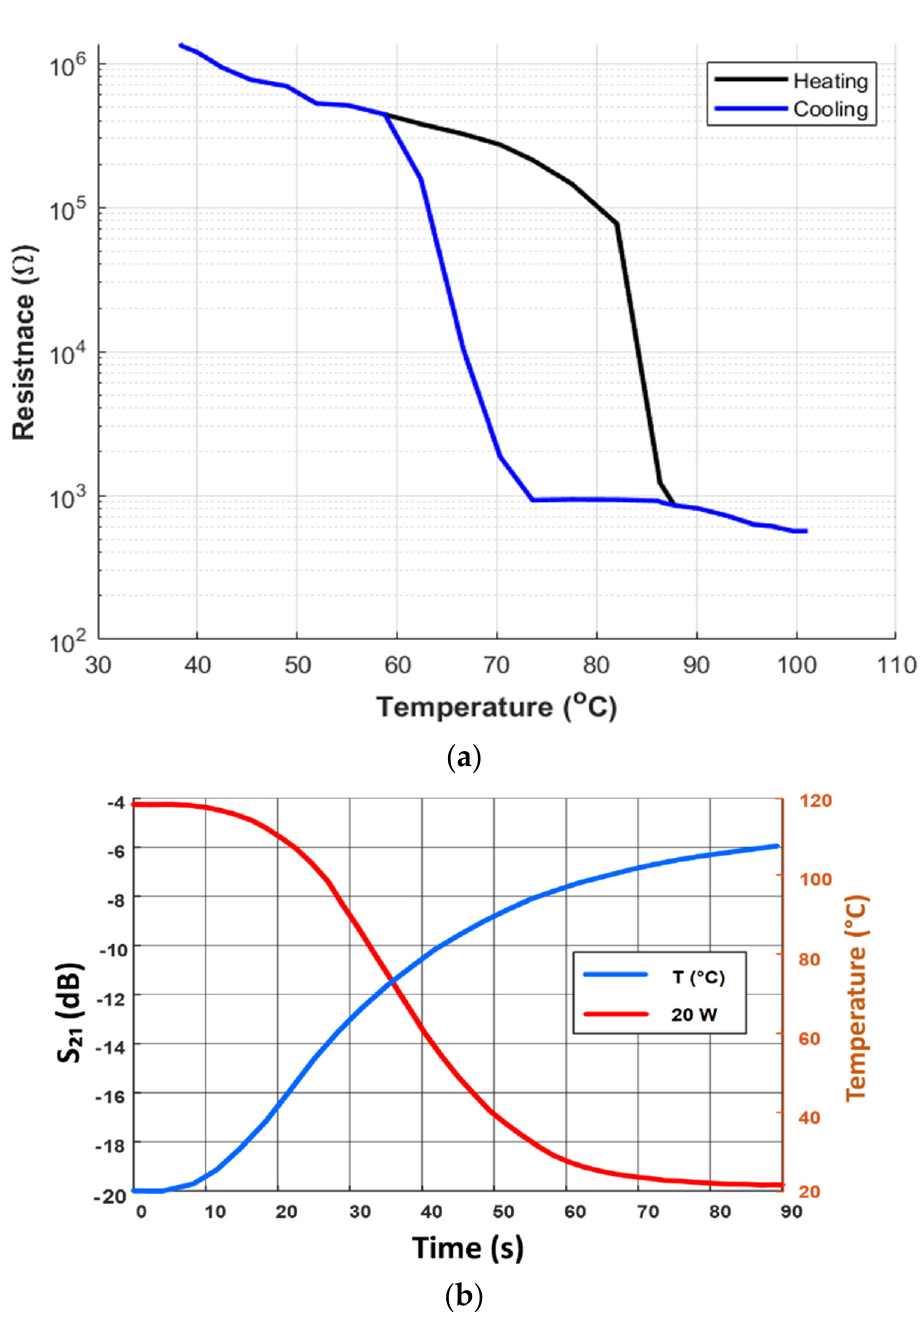
Figure 7. ( a ) Measured electrical resistance of VO 2 thin film during the heating and cooling phase. ( b ) Measured transmission characteristics of full wafer heating attenuated by 16 dB at 10 GHz.